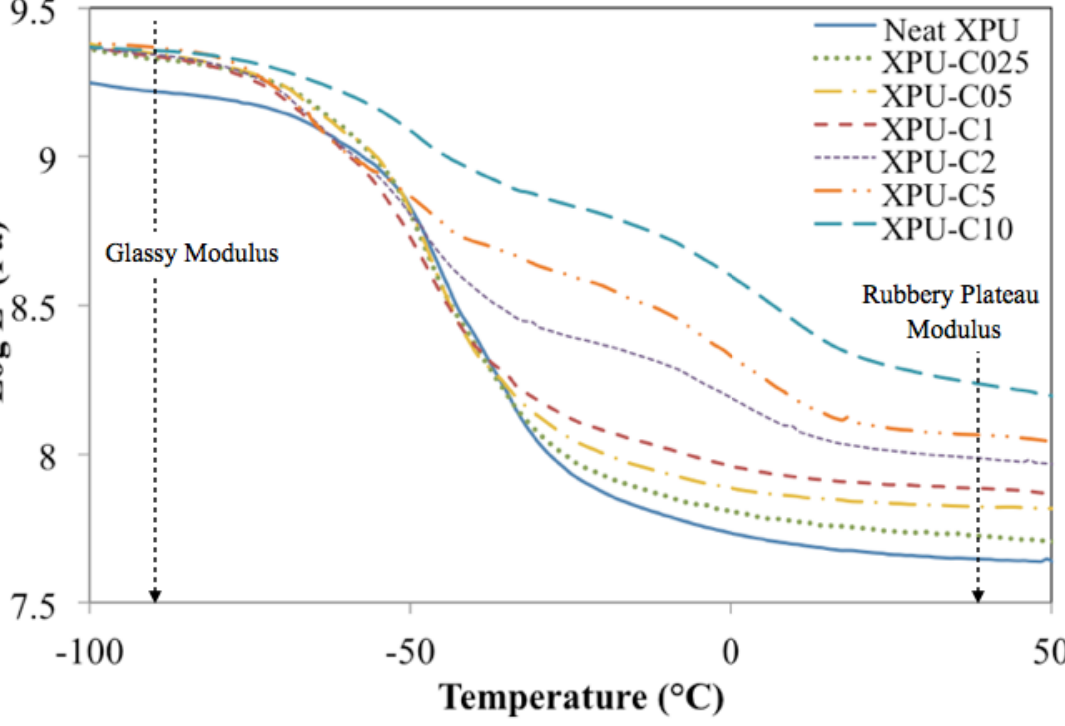
Figure 4. Variation in the storage modulus of the nanocomposites with temperature and composition.